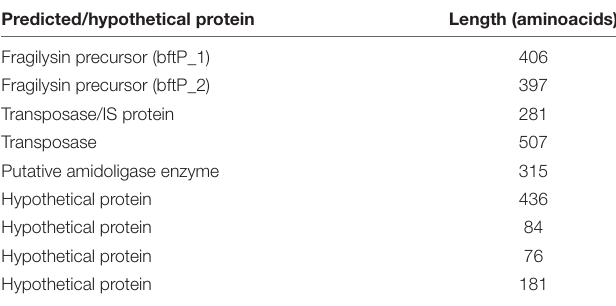
TABLE 2 | Distinctive B. fragilis coding